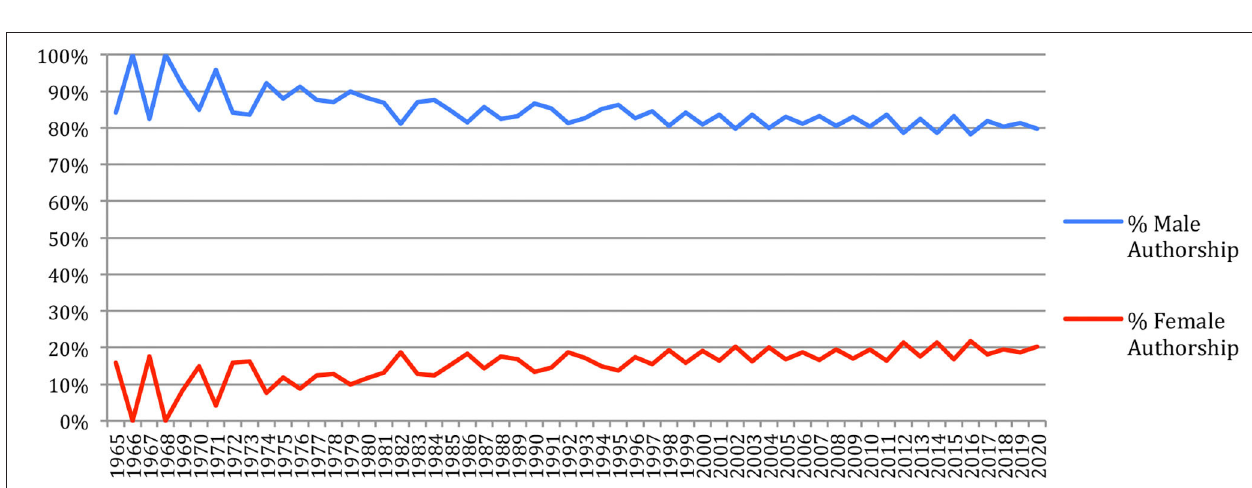
FIGURE 10 | Number of papers and authorships over time.